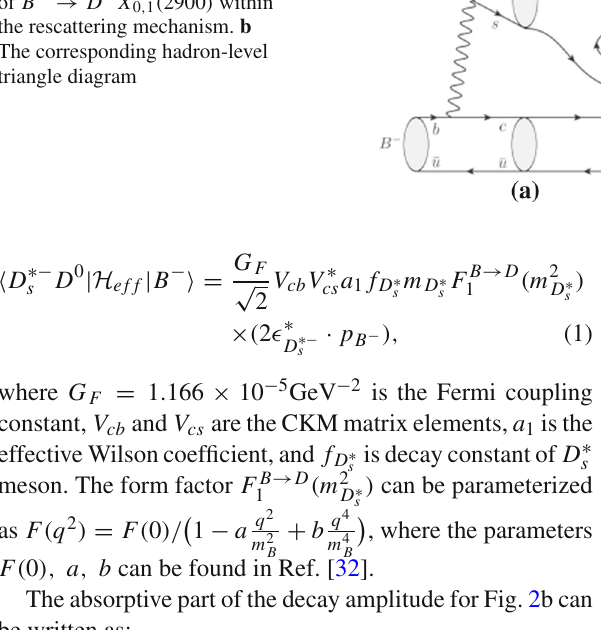
for X 1 . Due to the unknown structure of X 0 , 1 ( 2900 ) , the are unknown. required couplings of g X ∗ K ∗ or g X 0 , 1 D 0 , 1 D 1 K Therefore, we neglect such diagrams which doesn’t affect our fractions of B − → D − X 0 , 1 ( 2900 ) can be understood by the rescattering mechanism. The numerical results of the branching fractions of B − → D − X 0 , 1 ( 2900 ) are provided in Fig. 3. The red-dashed line and the blue-dashed line are experimental branching frac- tions for B − → D − X 0 and B − → D − X 1 , respectively. Light-grey shadow areas are experimental error for each decay mode. It can be seen that the theoretical predictions on the branching fractions at around η ≈ 3 . 0 are consis- tent with the experimental measurements. The production of X 0 , 1 ( 2900 ) in B − → D − X 0 , 1 ( 2900 ) can be understood by the rescattering